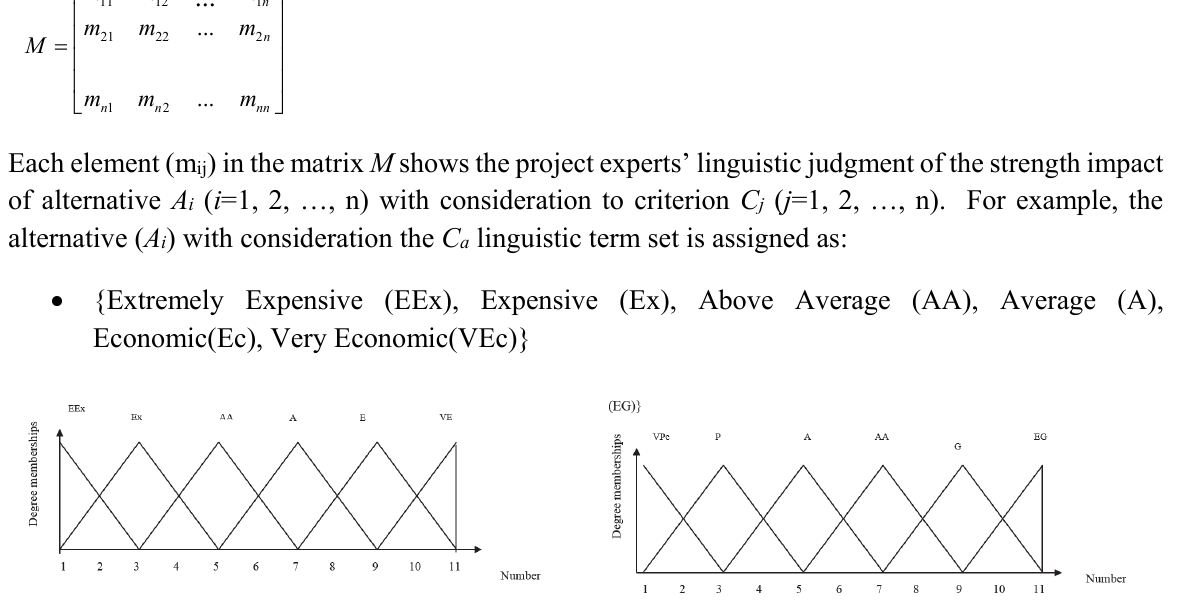
Fig. 3. Linguistic Terms C a in Fuzzy Judgment Matrix Fig. 4. Linguistic Terms C b in Fuzzy Judgment